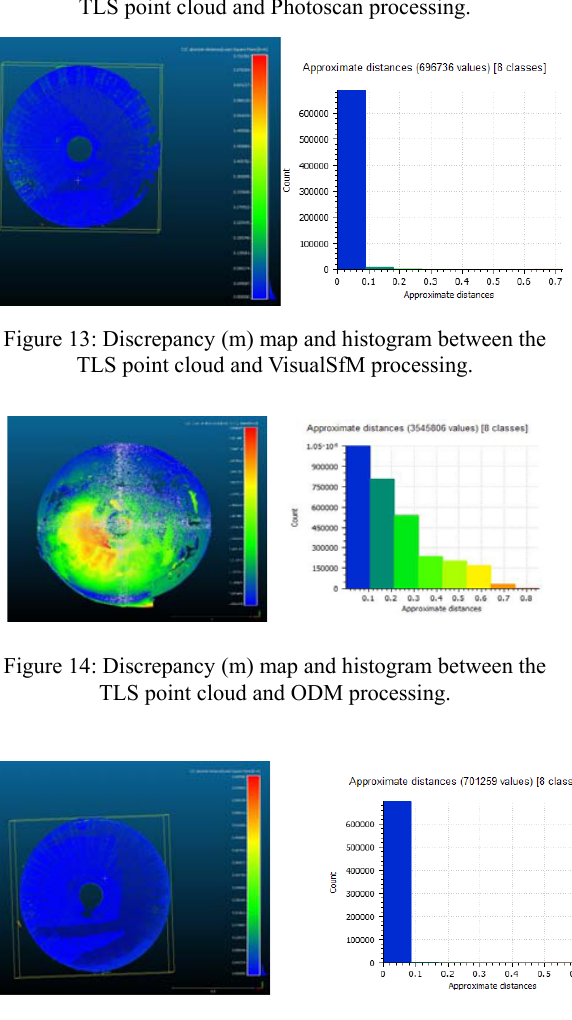
Table 2: Statistical values of the comparisons between the TLS data and the Photoscan point clouds.